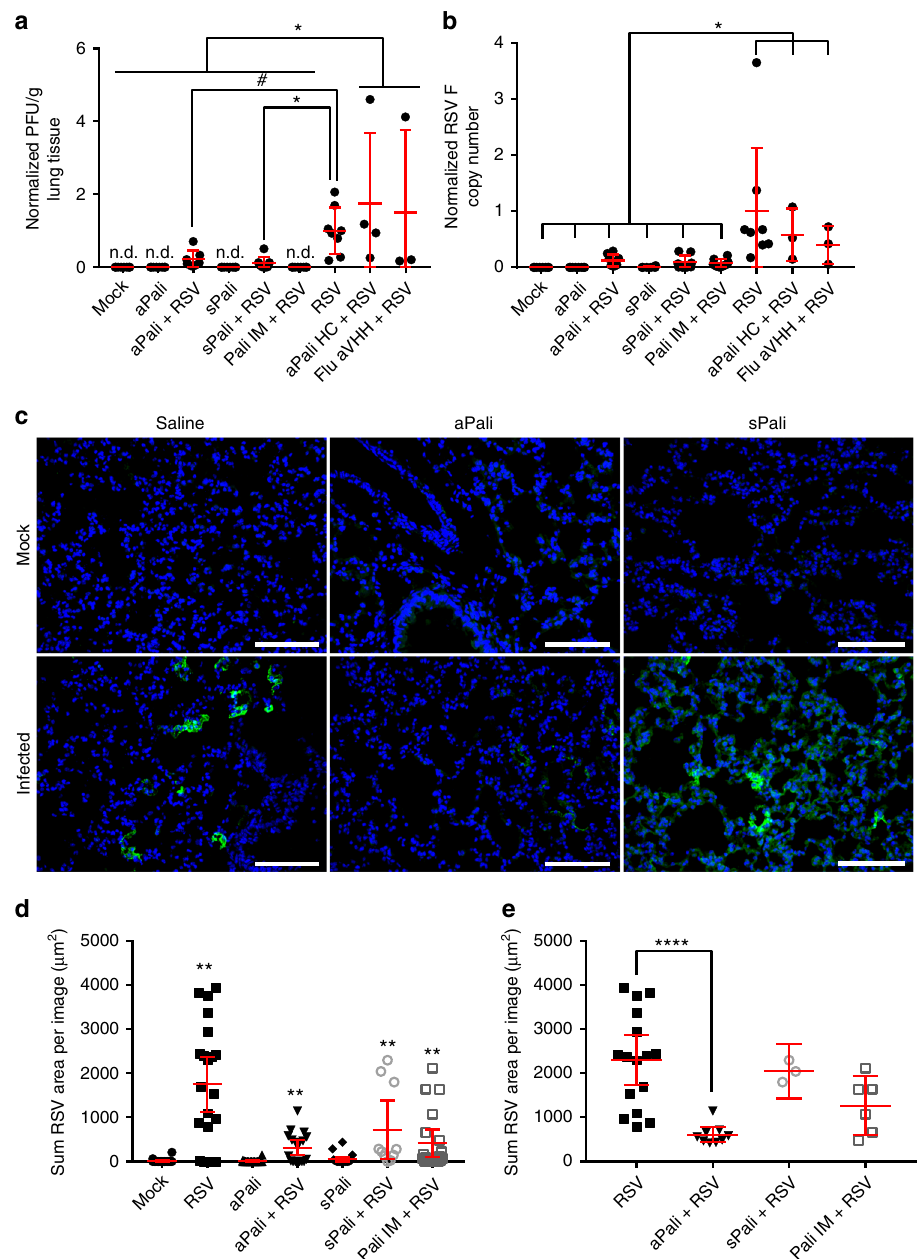
Fig. 5 mRNA-expressed palivizumab prevents RSV infection in vivo. Mice lungs were transfected with 100 μ g of naked aPali mRNA. Saline, negative, and irrelevant mRNA controls are indicated. 24 h later, mice were infected with RSV L19. At 4 days post infection, mice were sacri fi ced and lungs were excised. A total of 10 mice were used per group, out of which, 8 were processed for mRNA, protein, and virion extraction, with 2 being prepared for cryosectioning. aPali HC and Flu aVHH controls, along with a RSV only group, were performed in a separate experiment. a Virion content of mice lung homogenate supernatants was assayed by plaque assay. Error bars represent standard deviation. Asterisk indicates p < 0.05 ( t -test, one-tailed). Hash indicates p = 0.07. b Mean RSV F copy number was determined by qRT-PCR. Data was normalized by saline control. Error bars represent standard deviation. Asterisk indicates p < 0.05 ( t -test, one-tailed). c Cryosections were stained with panRSV antibody (green). Scale bar represents 100 μ m. d Quanti fi cation of mean volume of RSV signal per frame from microscopy images in part c . Error bars represent 95% con fi dence intervals. Asterisks indicate p < 0.01 (Kruskal- Wallis, Dunn ’ s multiple comparisons). e For thresholded comparison, images with less than 400 μ m 3 signal were excluded. Error bars represent 95% con fi dence intervals. Asterisks indicate p < 0.0001 (Kruskal – Wallis, Dunn ’ s multiple (Supplementary Fig. 12). In the RSV aVHH mRNA treated animals, but not the aPali or sPali mRNA treated animals, we observed an increase only in the CCL3 and CCL5 concentrations. Overall, we have demonstrated that mRNA-expressed neutraliz- ing antibodies in the lung are an effective method of preventing RSV infection in vivo without adverse cytokine responses.